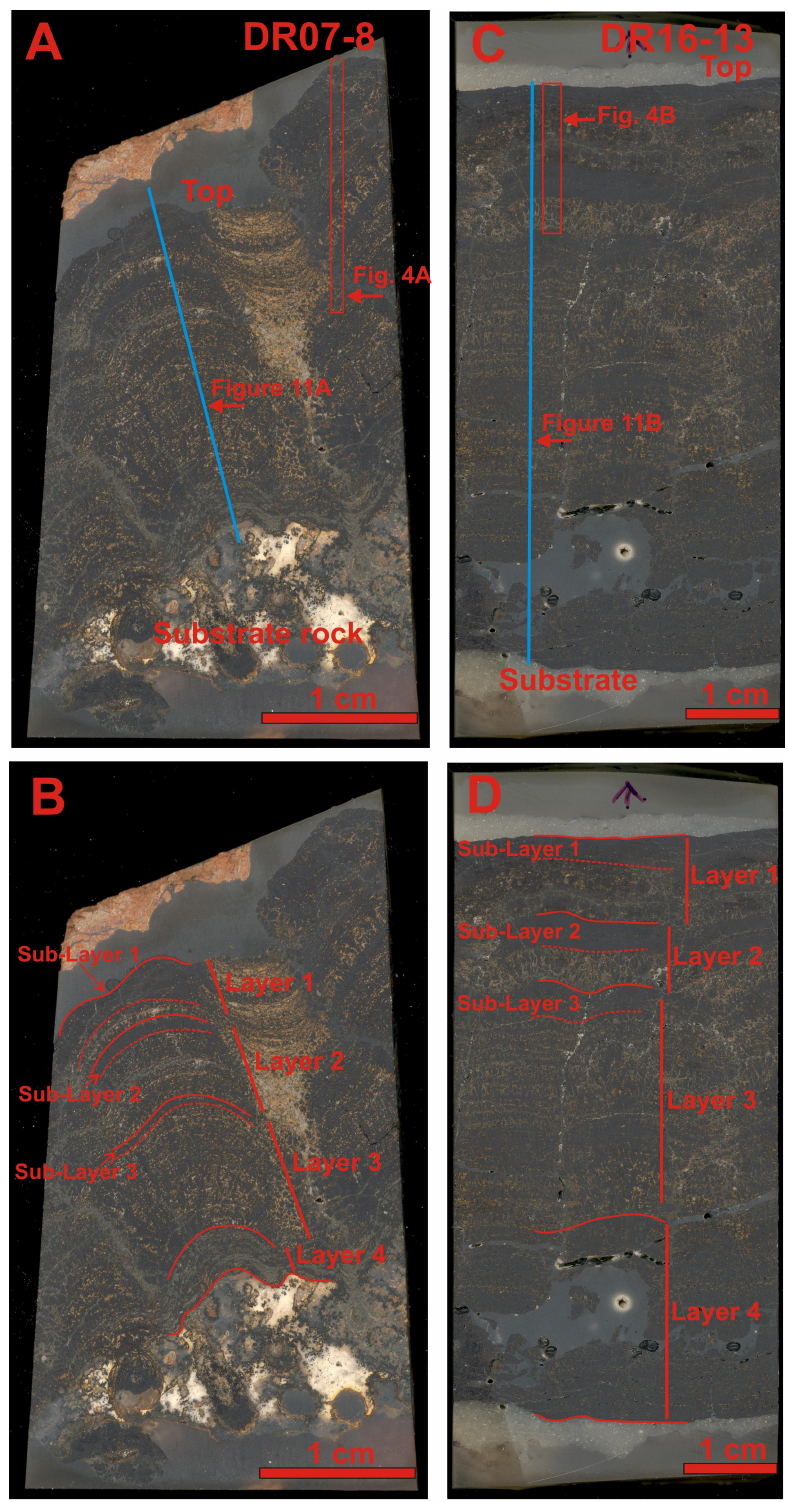
Figure 3. Cross polished section of the study crusts ( A , B ) DR07-8 and ( C , D ) DR16-13 which shows four main layers. Layers 1, 2, 3, 4 and sub-layers clearly visible in visu. The position of the layer-by-layer transect and continuous profile image obtained by optical microscopy is also